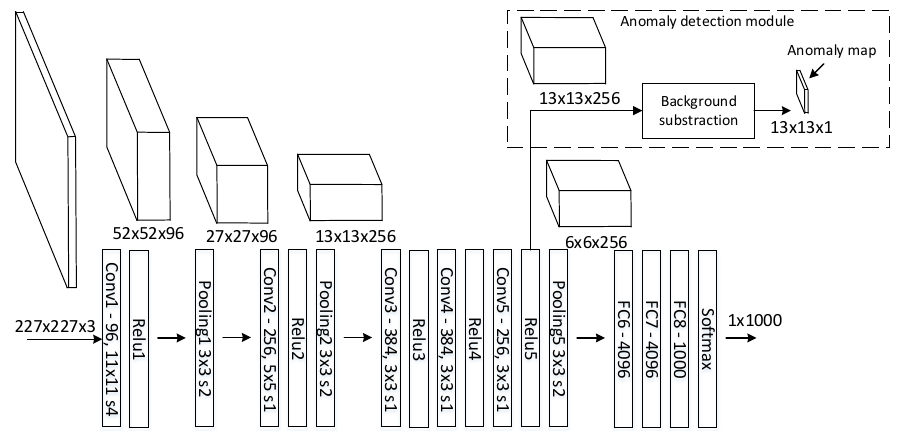
Figure 5. Caffe reference model [36] and the anomaly detection module. The notations of, e.g., “Conv1—96, 11 × 11 s4” mean that convolutional layer Conv1 has 96 kernels with a receptive field of 11 × 11 and a stride of four.